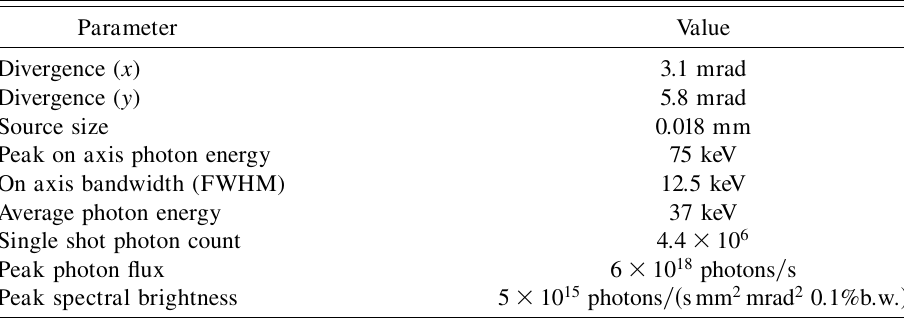
TABLE III. Measured x-ray beam characteristics. Source size and divergence parameters are the root mean square intensity values. The source size is inferred from measurements of the laser spot size and electron spot size. The spectral information is inferred from simulations of the Thomson interaction based on measurements of the electron beam characteristics, and the photon count and divergence is inferred from the CCD image of the x-ray beam (Fig. 2).